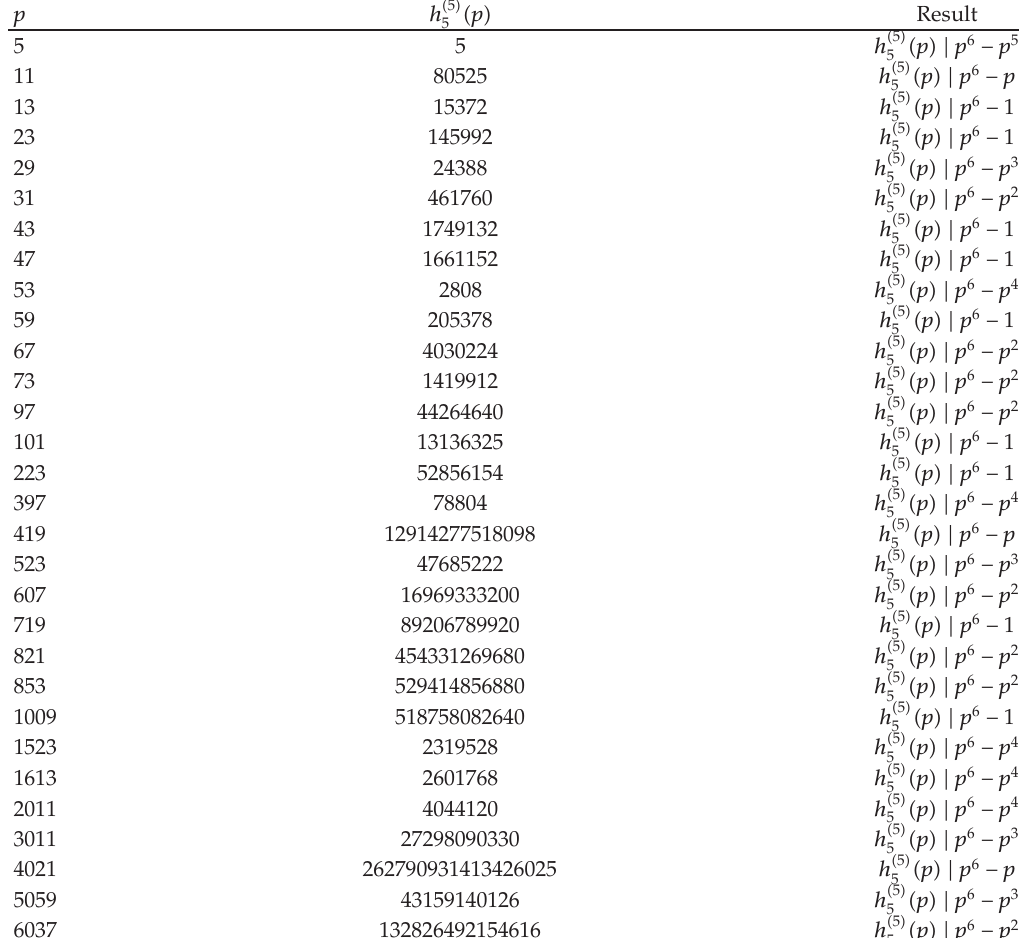
(cid:2) p (cid:3) 5